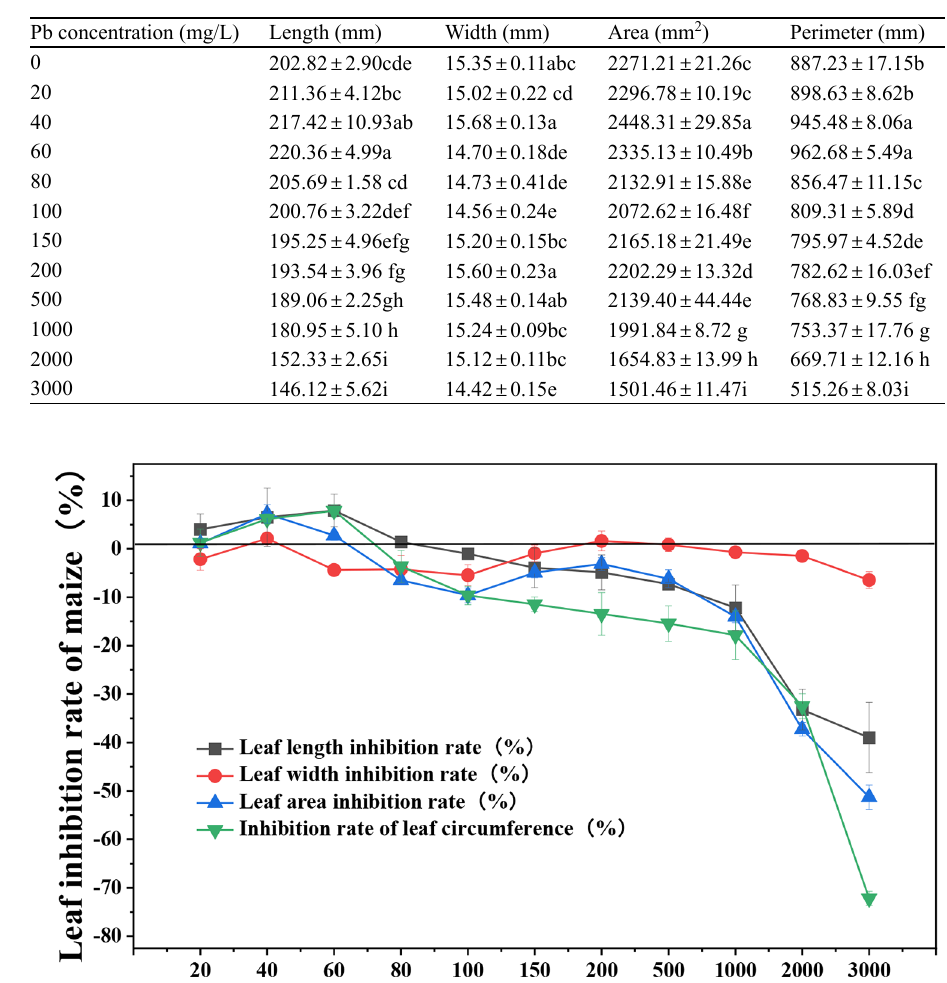
Table 4 Maize leaf traits under the different Pb